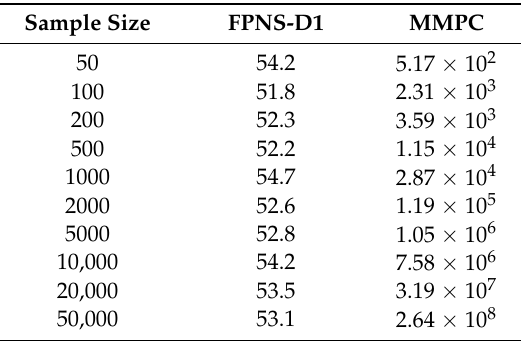
Table 1. The runtime of FPNS and MMPC.